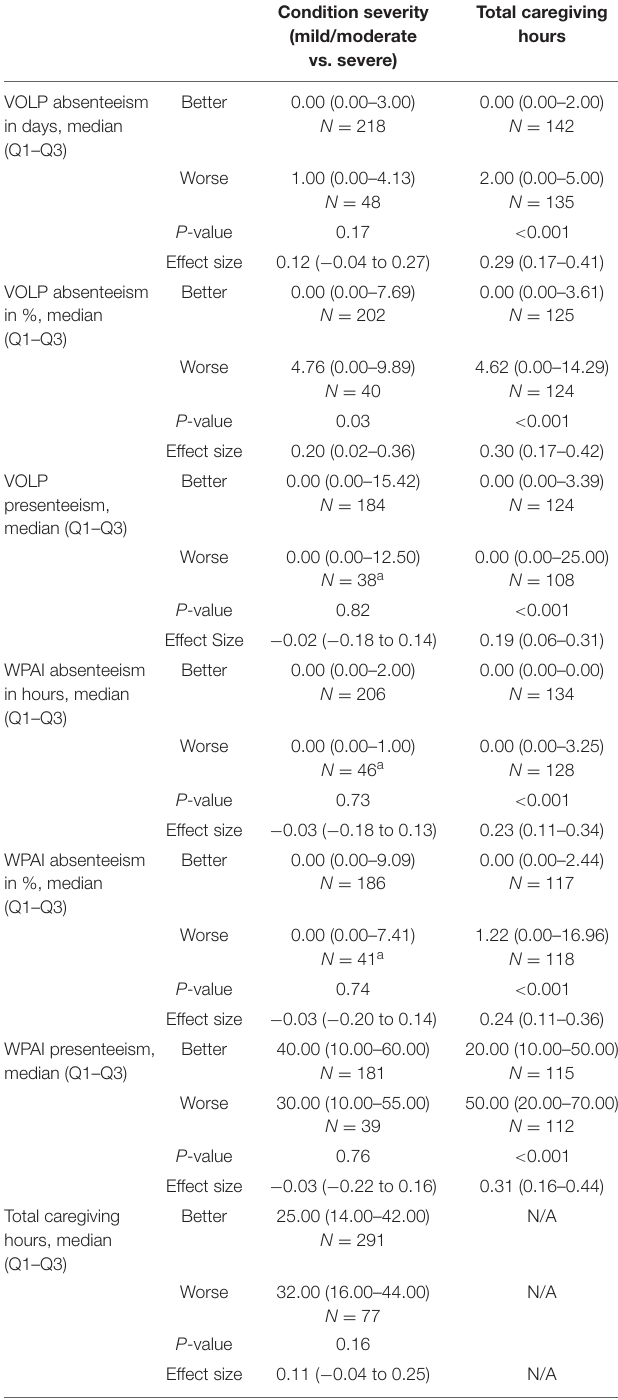
TABLE 4 | VOLP outcomes and WPAI outcomes between two different caregiver groups defined by the condition severity of care recipients and the median of total caregiving